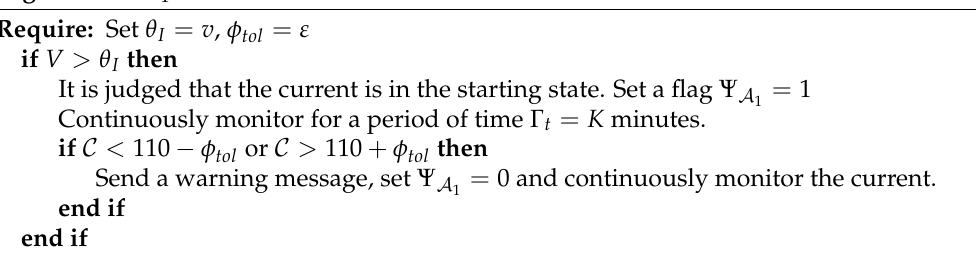
Algorithm 1 A 1 Determine the fan current